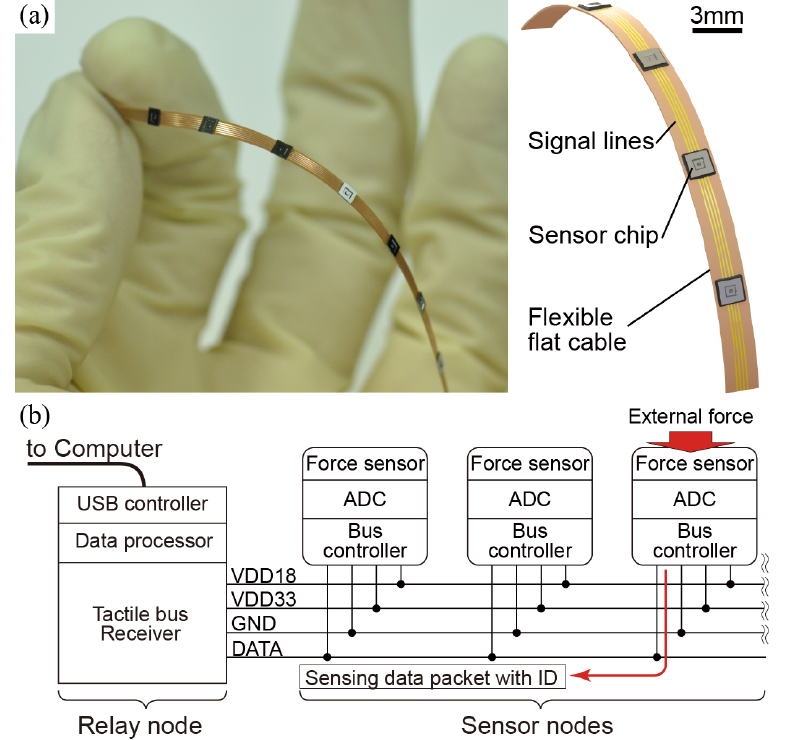
Figure 1. A tactile sensor network with small and smart sensor dies: ( a ) one-dimensional sensor array on a flexible cable; ( b ) tactile sensors with a force sensor and bus network interface on a